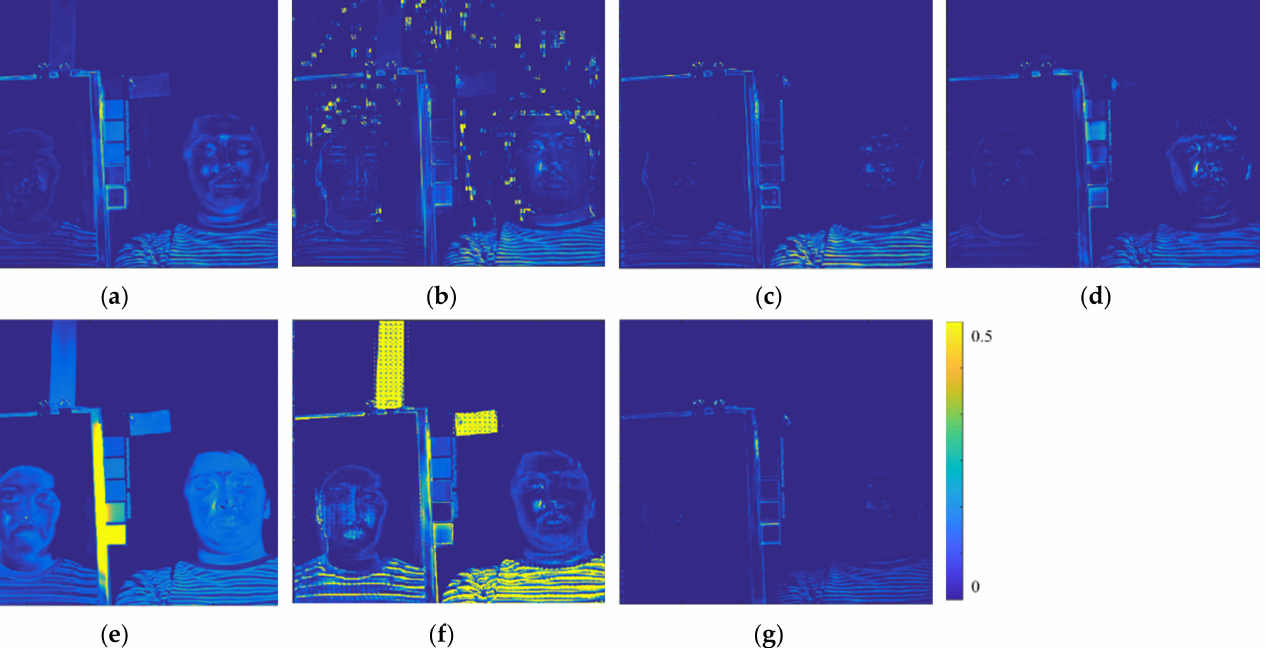
Figure 9. Residual information of CAVE dataset with real multispectral images. ( a ) results of GSA; ( b ) results of SFIMHS;